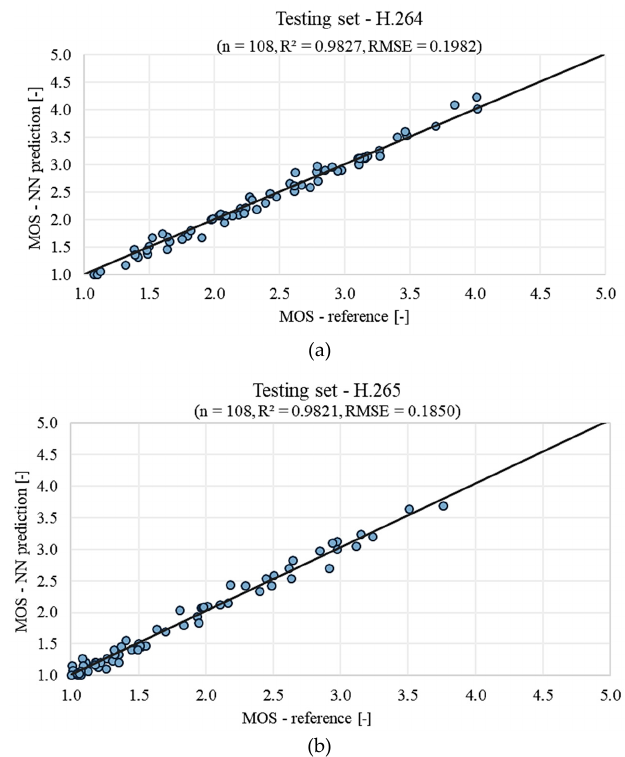
Figure 9. Correlation diagrams for H.264 ( a ) and H.265 ( b ).